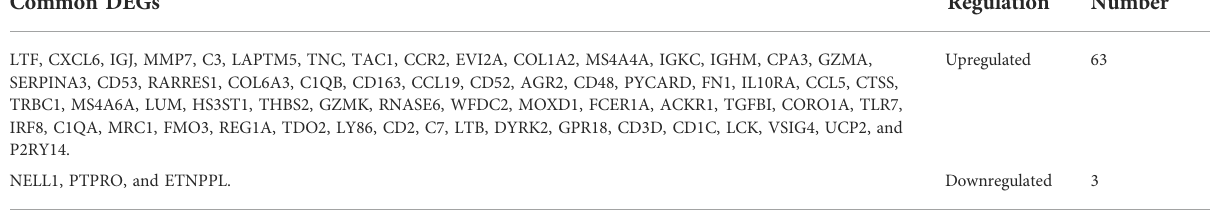
TABLE 1 Details of common